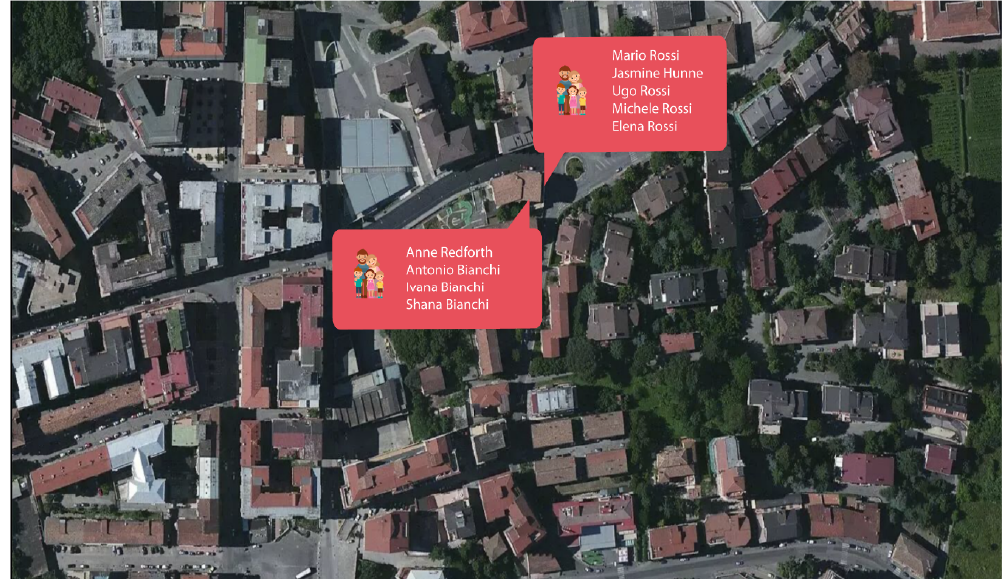
members. In this case, members of the two Family geometaphors located into the right building are Figure 8. A first disaggregation phase visualizing references to the families for each building. listed, once selected.